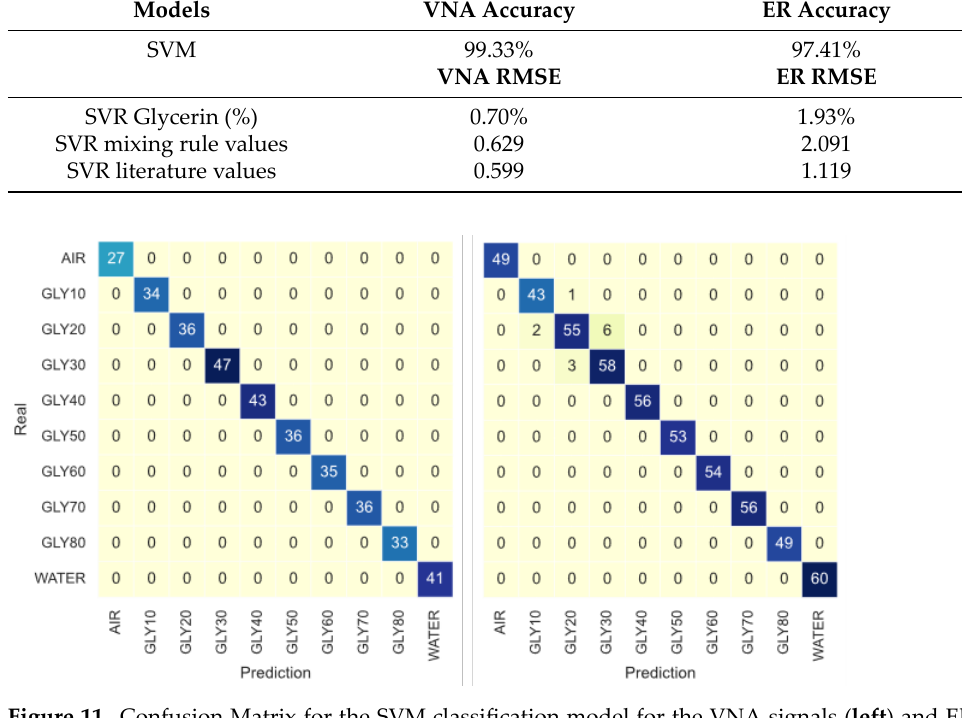
Figure 11. Confusion Matrix for the SVM classification model for the VNA signals ( left ) and Elec- tronic Reader signal ( right ).